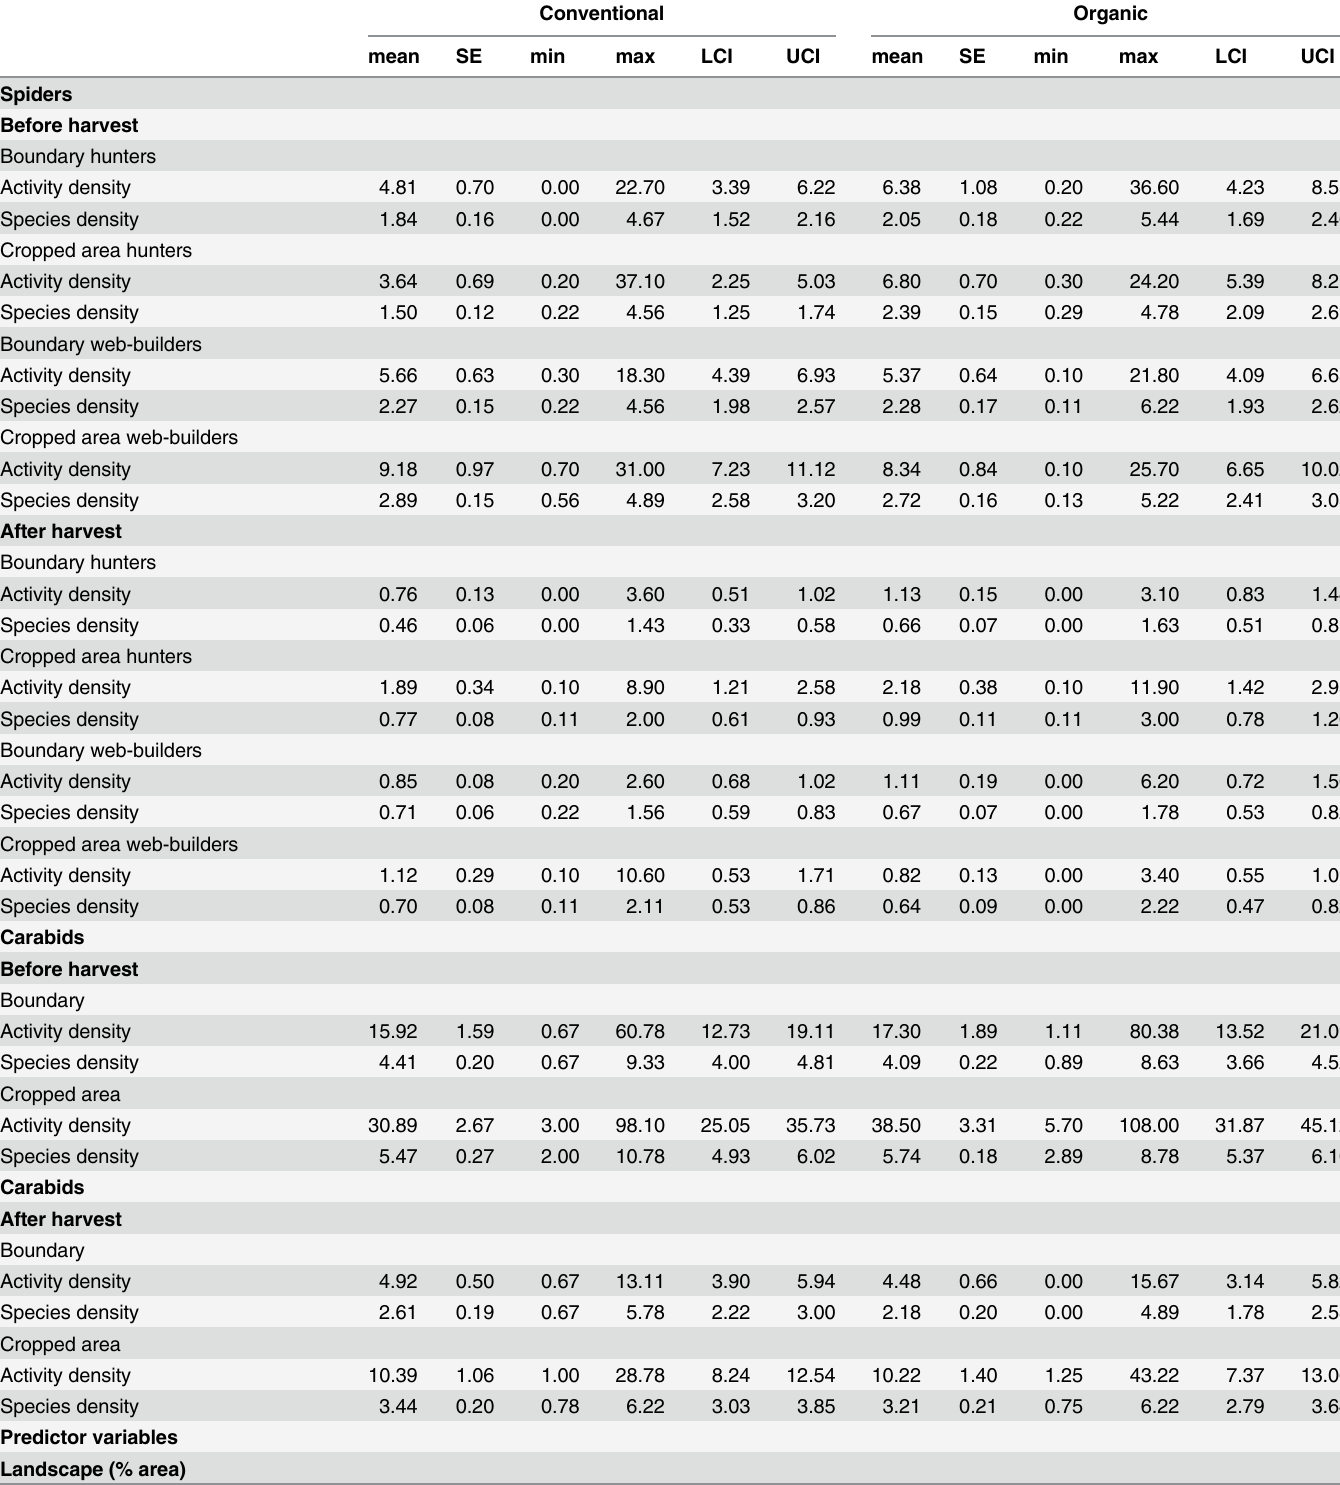
Table 1. Descriptive statistics for response variables (spiders and carabids), and predictor variables (landscape and field level) for conventional and organic farms. N = 60 farm pairs. Conventional